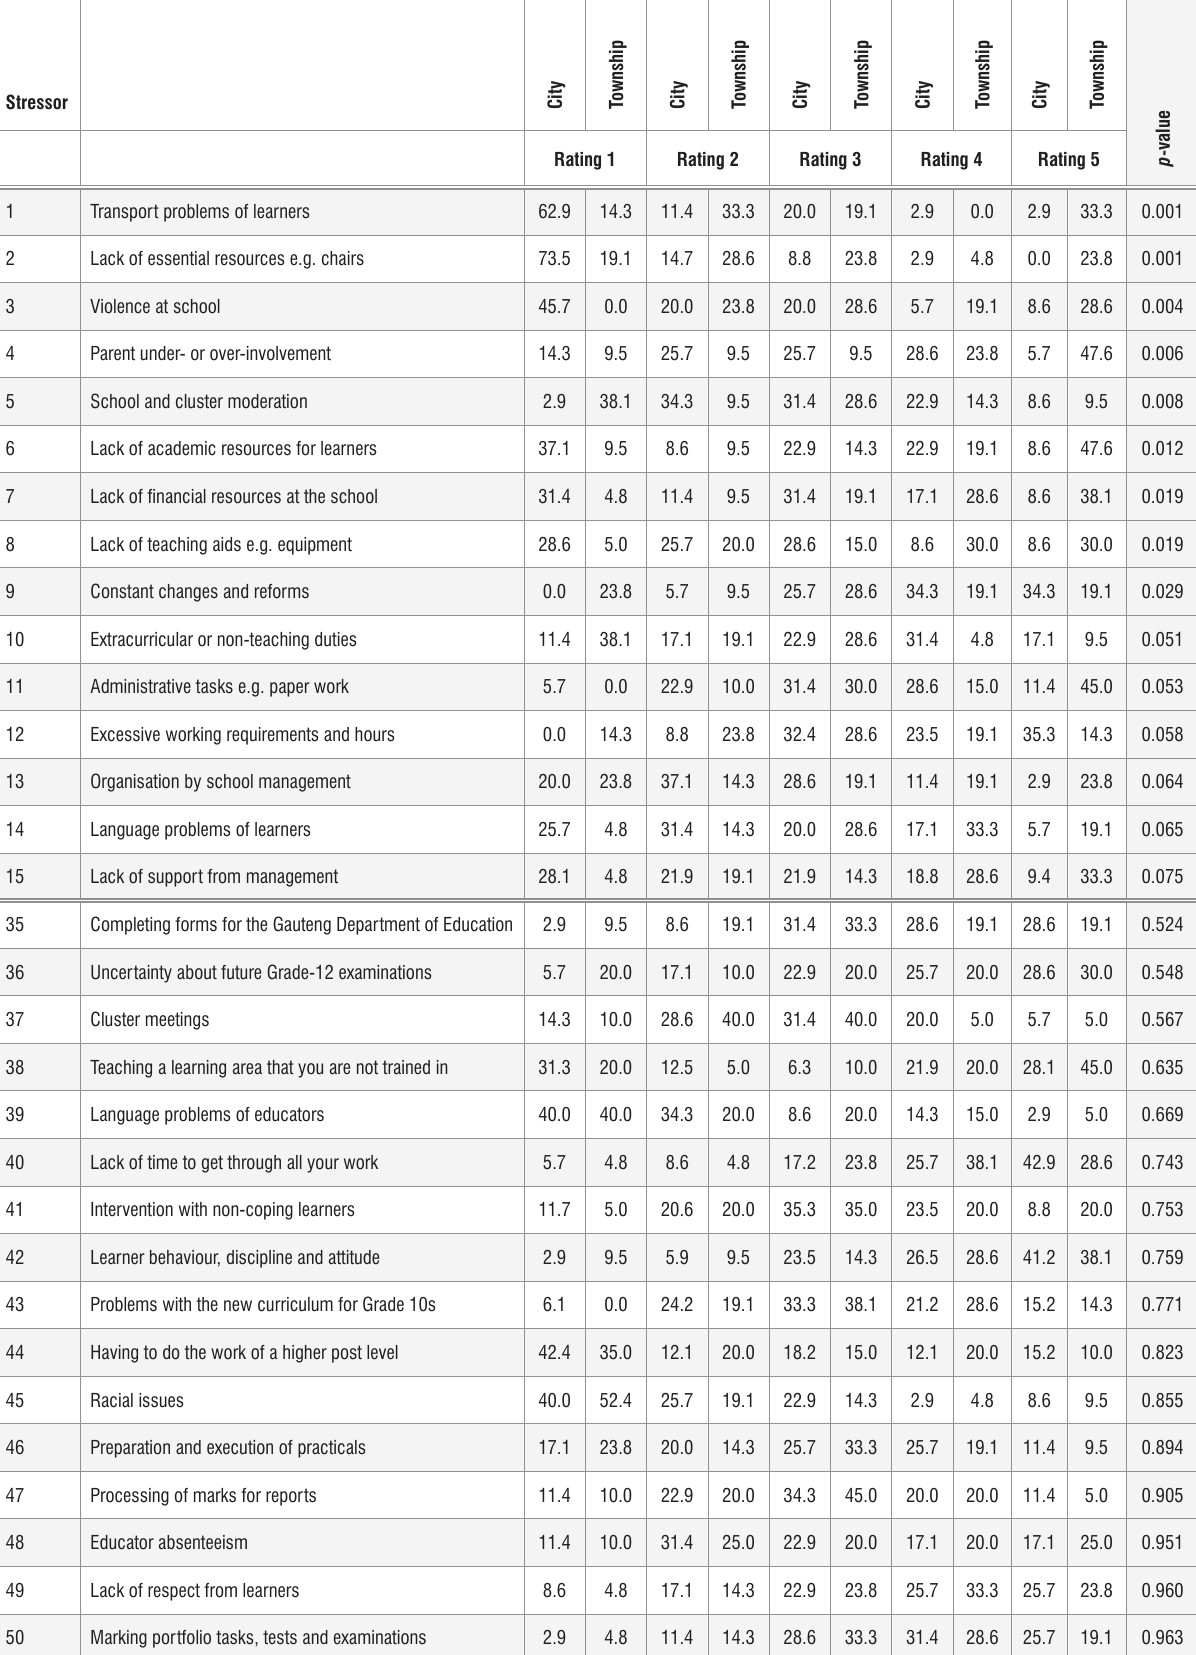
Table 3: Differences between the ratings of stressors by township and city school educators ranked in order of significance (indicated as a percentage)